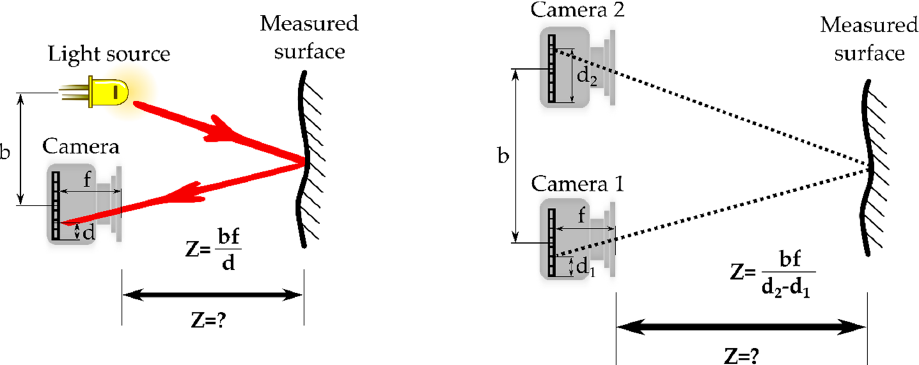
Figure 2. Schematic representation of light beam ( left ) and stereo vision ( right ) triangulation. “ Z ”, depth; “ b ”, baseline length; “ d ”, position of the incoming light beam on the image sensor; and “ f ”, focal length.